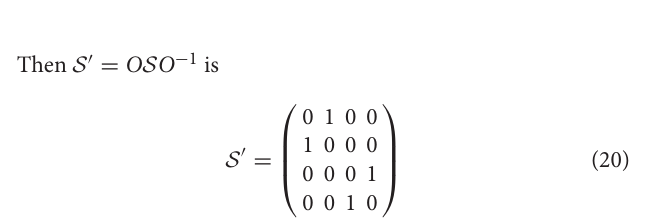
FIGURE 4 | Elimination corresponds to the deletion of contacts. In the simplest case only one contact is removed. The resulting matrix form is obtained by omitting the row and column of the eliminated contact. A matrix formalism for the elimination processes can be found in the Supplementary Information